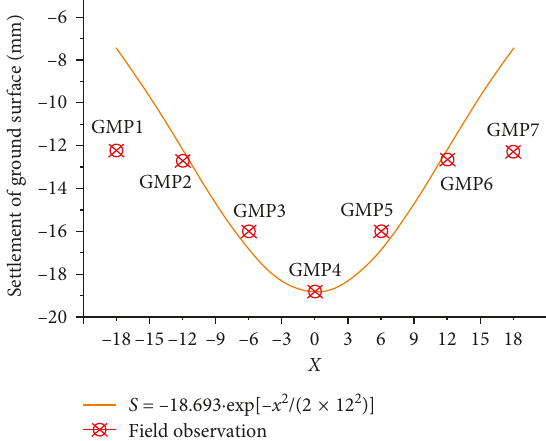
Figure 19: Calculation results and settlement value of GMP1 ∼